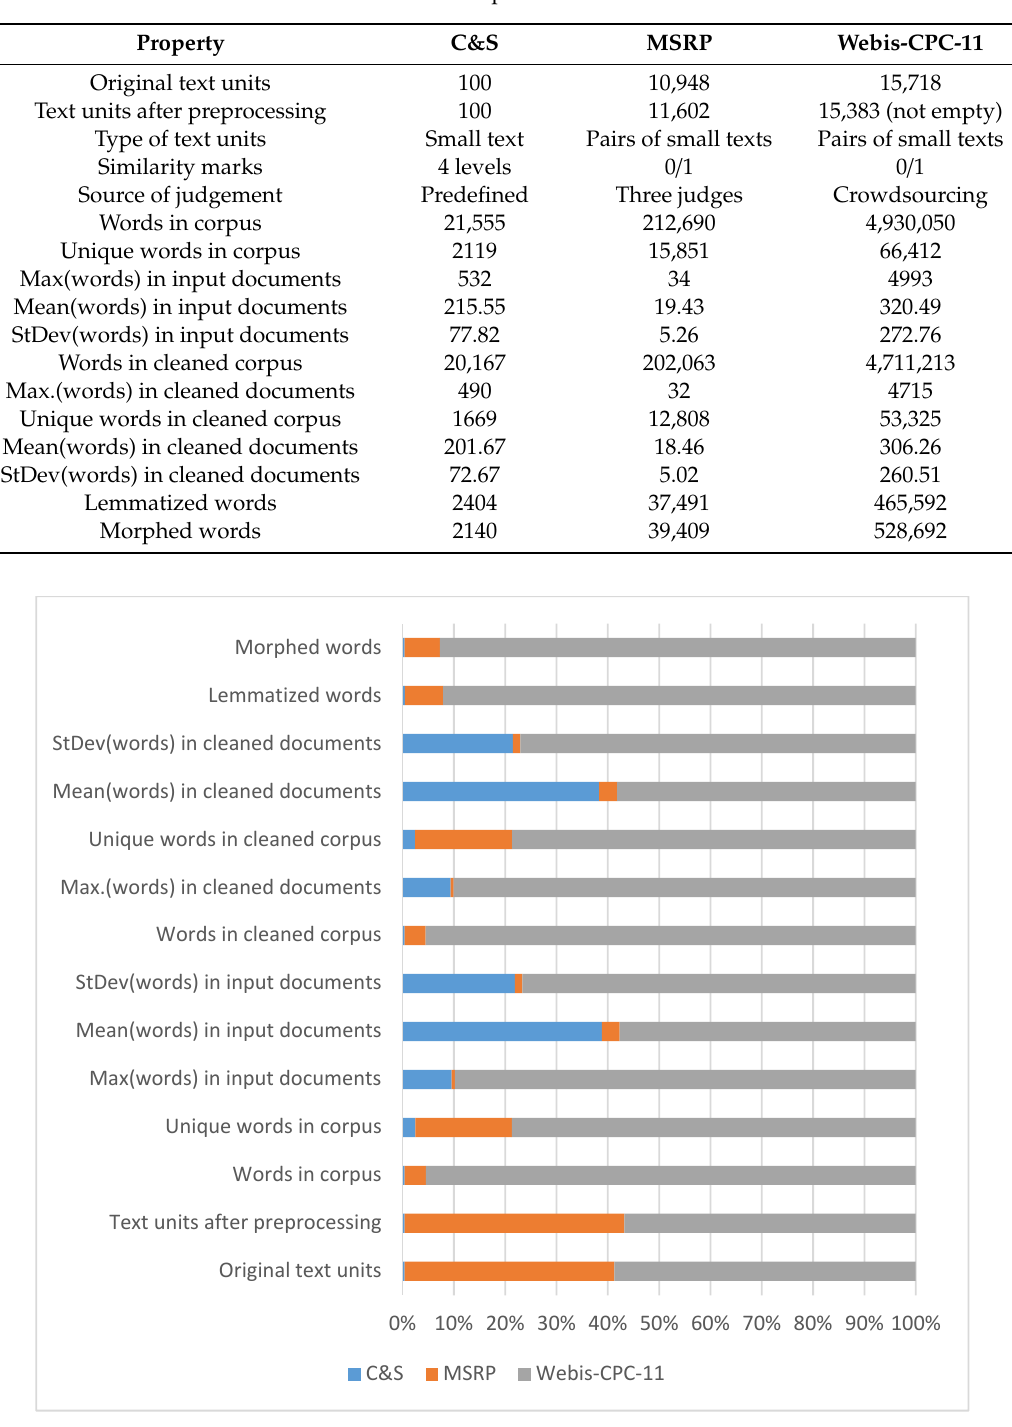
Figure 2. Corpora metadata.